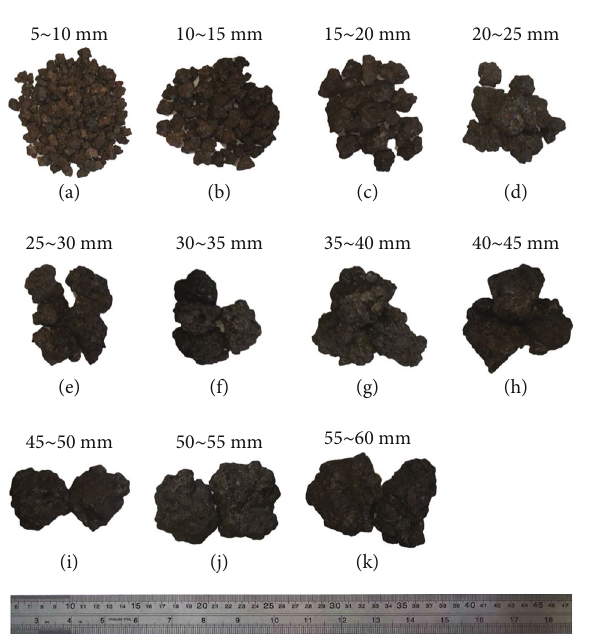
Figure 2: Photographs taken on 11 kinds of the sieved sinter samples within the ranges of (a) 5 ~ 10 mm, (b) 10 ~ 15mm,